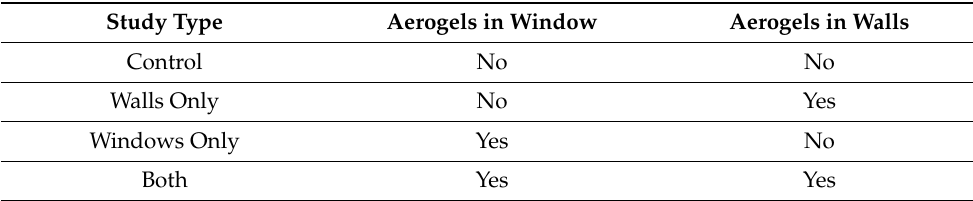
Table 1. Parametric study.